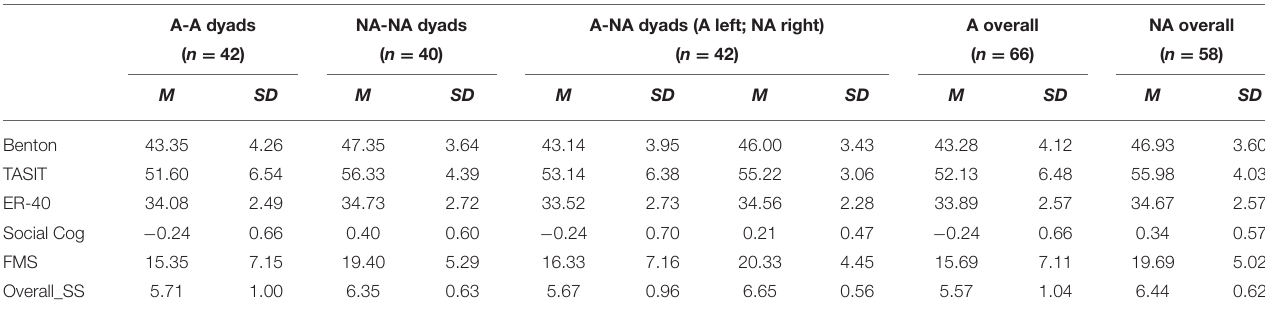
TABLE 3 | Scores on predictors for diagnostic and dyad